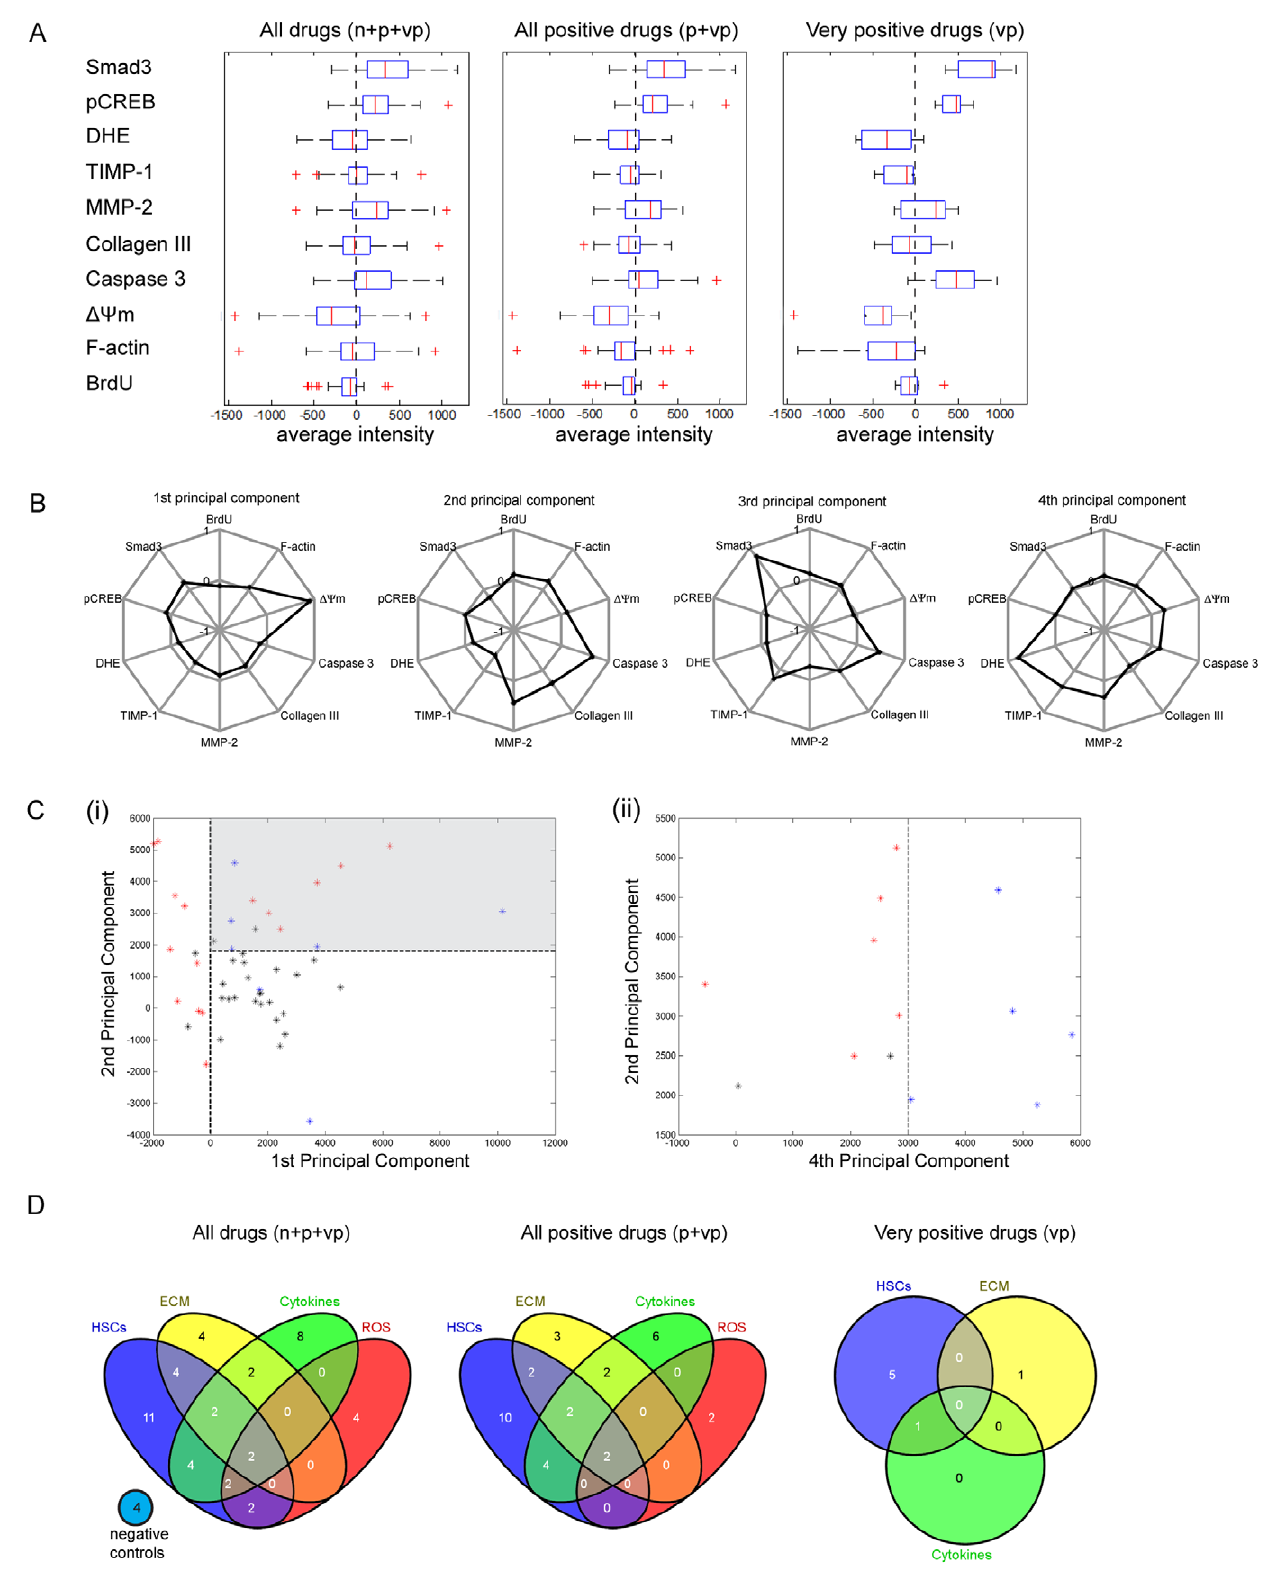
Figure 4. Distinctive characteristics of the negative (n), positive (p), and very positive (vp) groups of drugs. (A) The average intensities of the 10 makers for all drugs (n + p + vp), all positive (p + vp) drugs and the vp group of drugs are shown in the boxplots, where inter-quartile ranges are represented by boxes. Whiskers represent 1.5 times the inter-quartile range and any data (outliers) beyond the whiskers are shown using red + . (B) Principal component analysis (PCA) is done using data from the vp group. The top 4 principal components explain 95% of the cumulative variance in